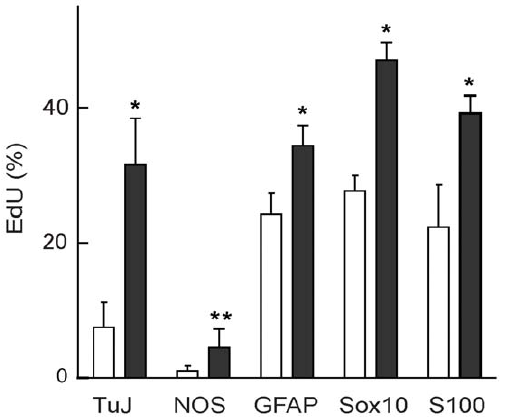
Figure 4. Analysis of proliferation of mouse neurosphere cells expressing neuronal and glial markers. Neurosphere cells were dissociated and allowed to attach to chamber slides immediately after a 1 h pulse of 10 m M EdU (open columns), or after a 96 h chase in the absence of EdU (closed columns). The vertical axis shows the percentage of cells positive for specific phenotypes that had also incorporated EdU. Error bars represent SEM (n=3 separate experi- ments). A two-tailed t-test was performed for differences between before and after chase (open and closed columns) for each marker. * p , 0.05; ** p ,